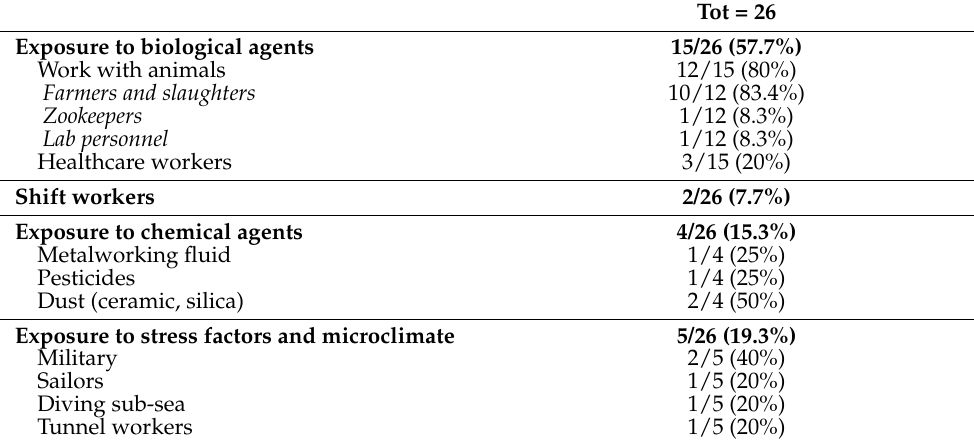
Table 4. Occupational exposure and workers’